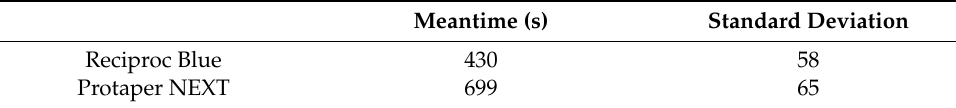
Table 2. Mean preparation time (s) for Reciproc Blue and Protaper NEXT file